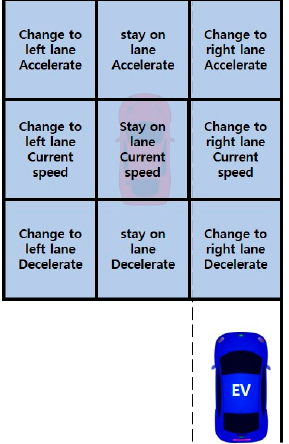
( b ) Figure 4. ( a ) In the case of keeping the lane in the same lane, Estimated location using V2V com- munications and LIDAR; ( b ) In the case of changing the lane in the adjacent lane, Estimated loca- tion using V2V communications and LIDAR. 4. Prediction System